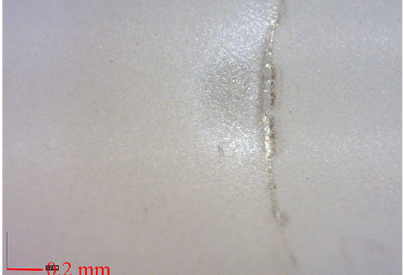
FIG. 25. Microscope image showing breakdown damage at the triple-point edge of the sapphire rod.